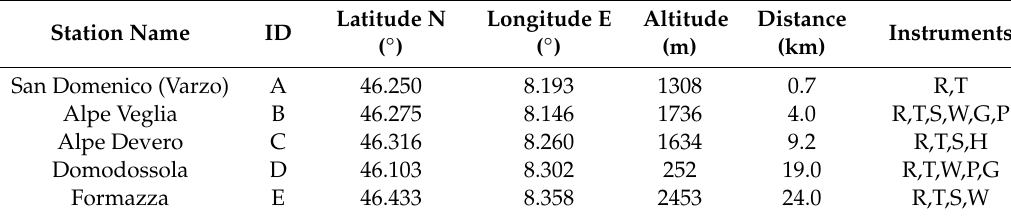
Table 1. The weather station positions and their distance from the Croso stream. Measured variables: R, rain; T, temperature; S, snow height; W, wind speed and direction; P, atmospheric pressure; G, global radiation; H, humidity. See locations reported in Figure